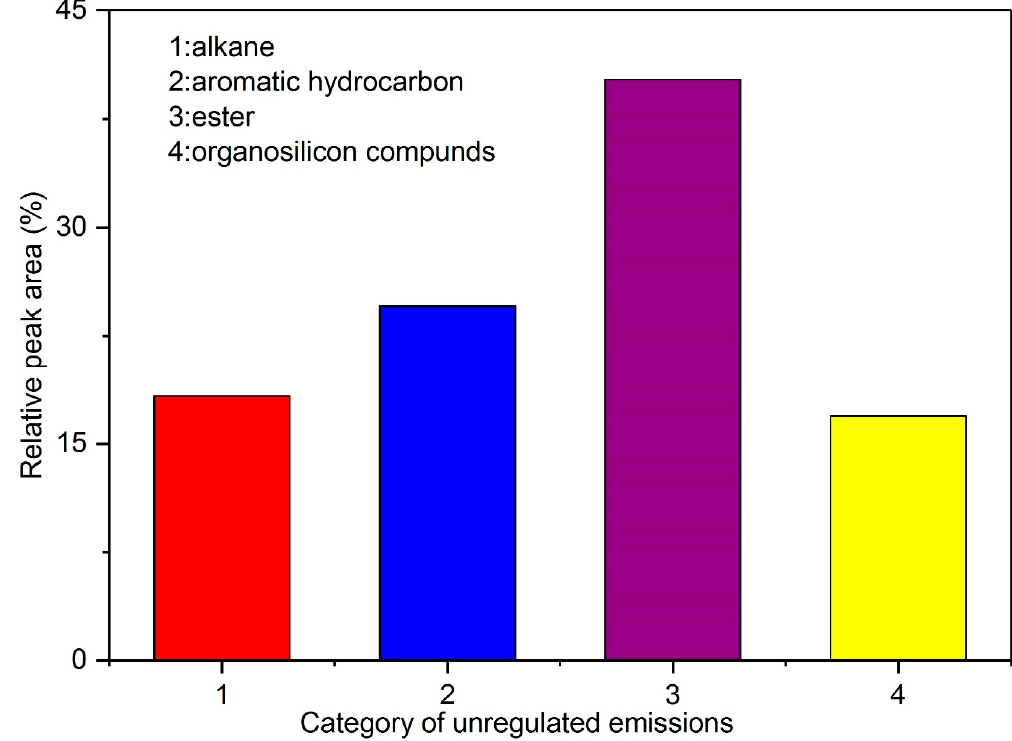
Figure 10. Relative concentration of unregulated emissions absorbed by absorption liquid in PPCI.